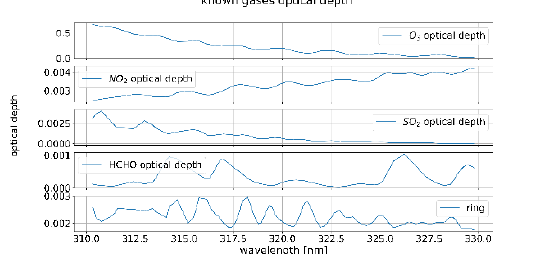
Figure 2 Known optical depths of species fitted for the retrieval of total vertical column of O 3